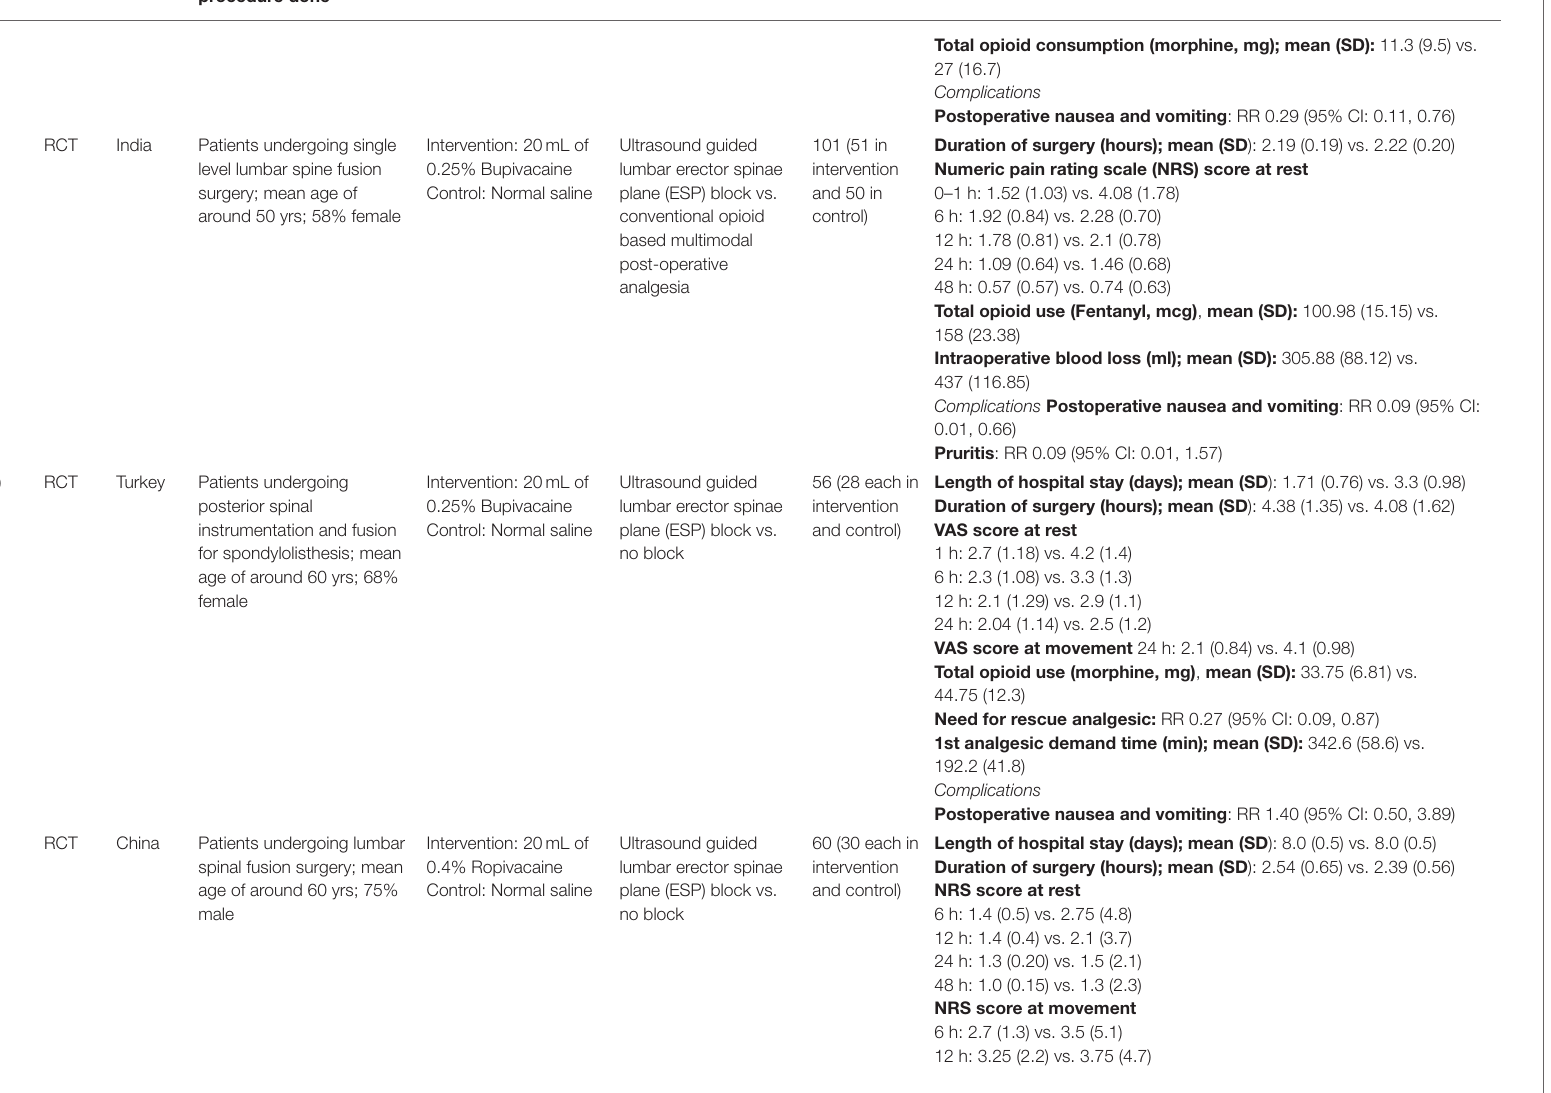
Intervention: 20mL of 0.25% Bupivacaine Control: Normal saline